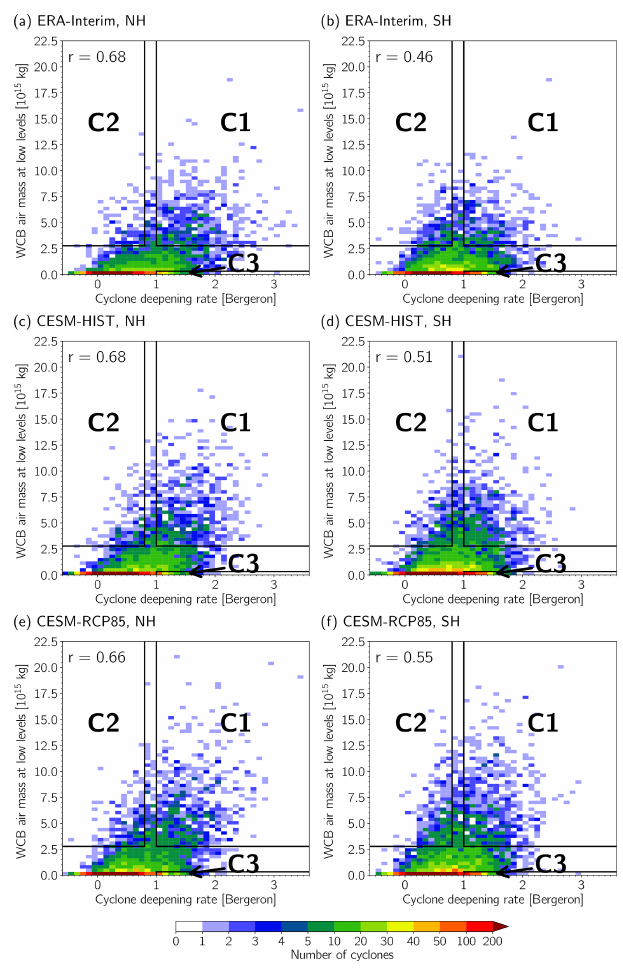
Figure 2. Two-dimensional histograms showing for all (a, c, e) NH and (b, d, f) SH winter cyclones in (a, b) ERA-Interim, (c, d) CESM-HIST, and (e, f) CESM-RCP85 the cyclone intensifica- tion rate (cid:49) SLP B , max (bin width = 0.1 bergerons) and the WCB strength (bin width ≈ 0 . 33 × 10 15 kg, corresponding to 250WCB trajectories). The colours specify the number of cyclones per bin. The black lines mark the borders of categories C1, C2, and